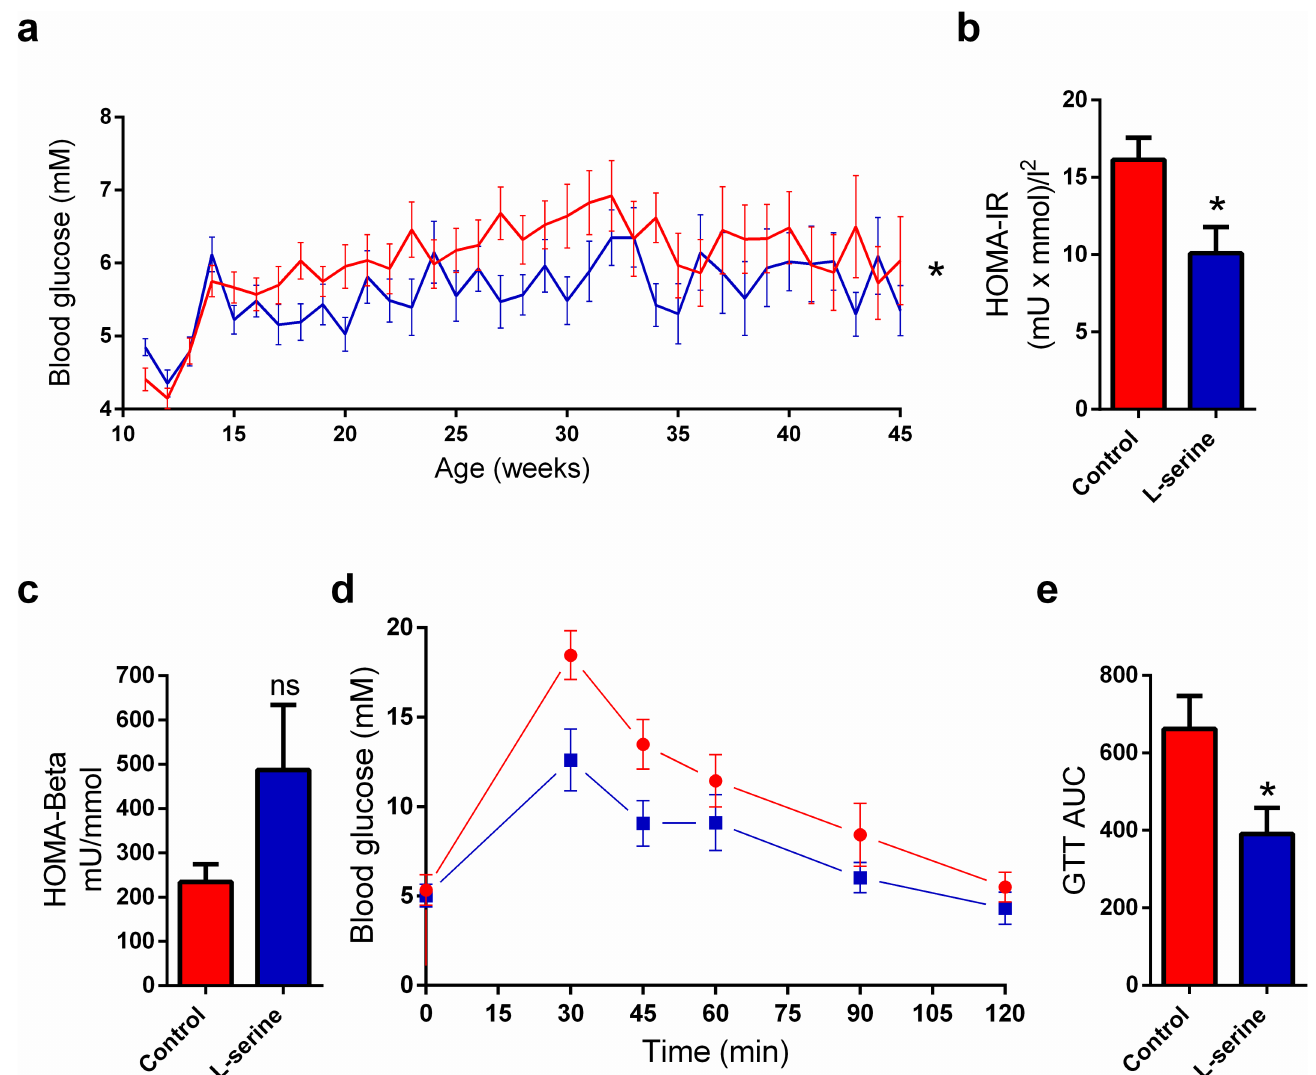
Fig 2. L-serine supplementation improves glucose homeostasis. (a) Blood glucose levels in healthy NOD mice up to 45 weeks of age, control (n = 46) and L- serine (n = 30), p = 0.047. Homeostasis model assessment of insulin resistance (HOMA-IR) (a) and beta-cell function (HOMA-Beta) (b) was assessed in mice age 13 weeks based on fasting insulin and blood glucose concentration (n = 4) p = 0.03 and p = 0.15, respectively. (d) Glucose tolerance test (GTT) was performed on healthy NOD mice age 45 weeks, which were injected with 1M glucose 0.01ml/g body weight. Blood glucose was measured at the indicated time (n = 5). (e) Area under the curve (AUC) calculation for the GTT, p = 0.04. Control is shown in red and L-serine in blue. Statistical tests: mixed model (a) and unpaired two-tailed Student’s t -test (b, c, and e). Data shown as mean ± SEM. (cid:3) p <